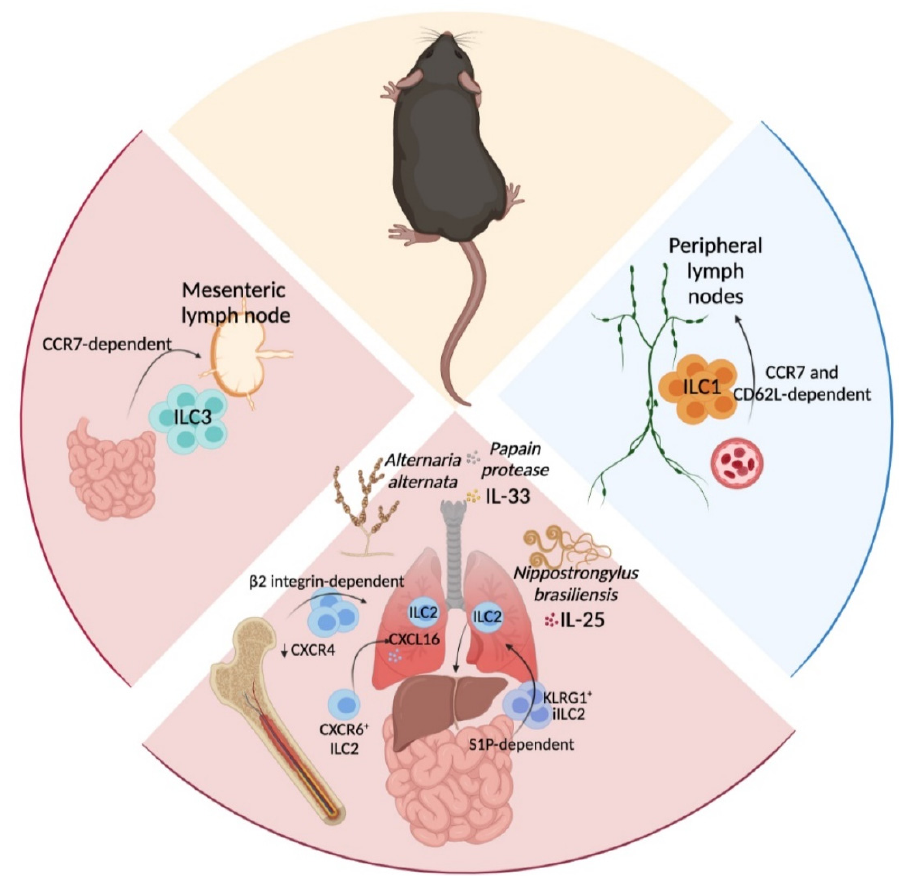
Figure 1. Murine ILC migrate interorgans under physiological and pathogenic conditions. The above schematic representation summarizes ILC trafficking pathways. At steady state, ILC1 migrate to the peripheral lymph nodes using the blood stream in a CCR7 and CD62L-dependent manner. In contrast, ILC2 and ILC3 traffic to lymph or blood stream following inflammatory insults. ILC2 migrate from bone marrow and small intestine to populate the lung. In addition, lung ILC2 migrate to the liver. Intestinal ILC3 mainly traffic from and to mLN to promote a local inflammatory immune response. This figure has been created with BioRender.com.